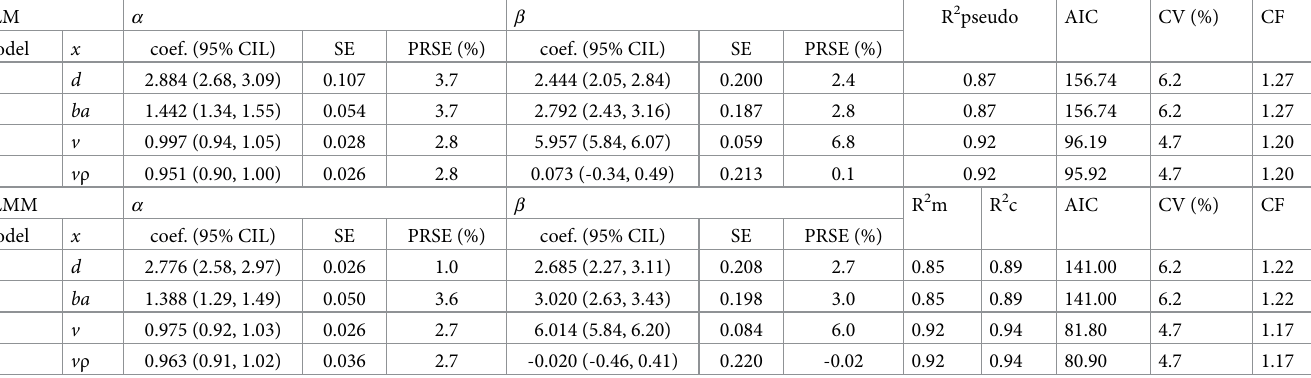
Table 3. Comparison of generalized linear models (GLMs) and generalized linear mixed-effect models (GLMMs) to estimate individual-tree aboveground biomass, based on different explanatory variables ( x ): diameter ( d ), basal area ( ba ),volume ( v ), and volume (cid:1) wood density ( v ρ ). GLM α